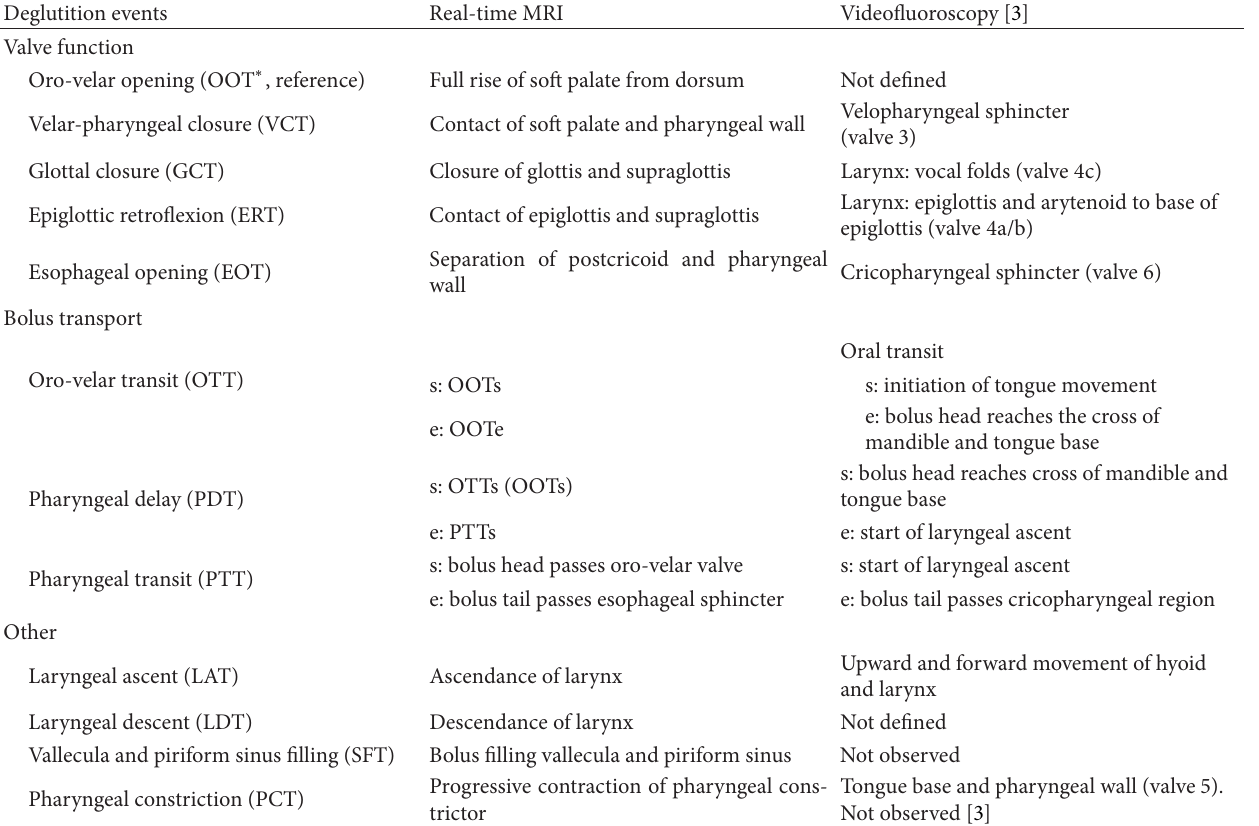
Table 1: Swallowing events revealed by real-time MRI and